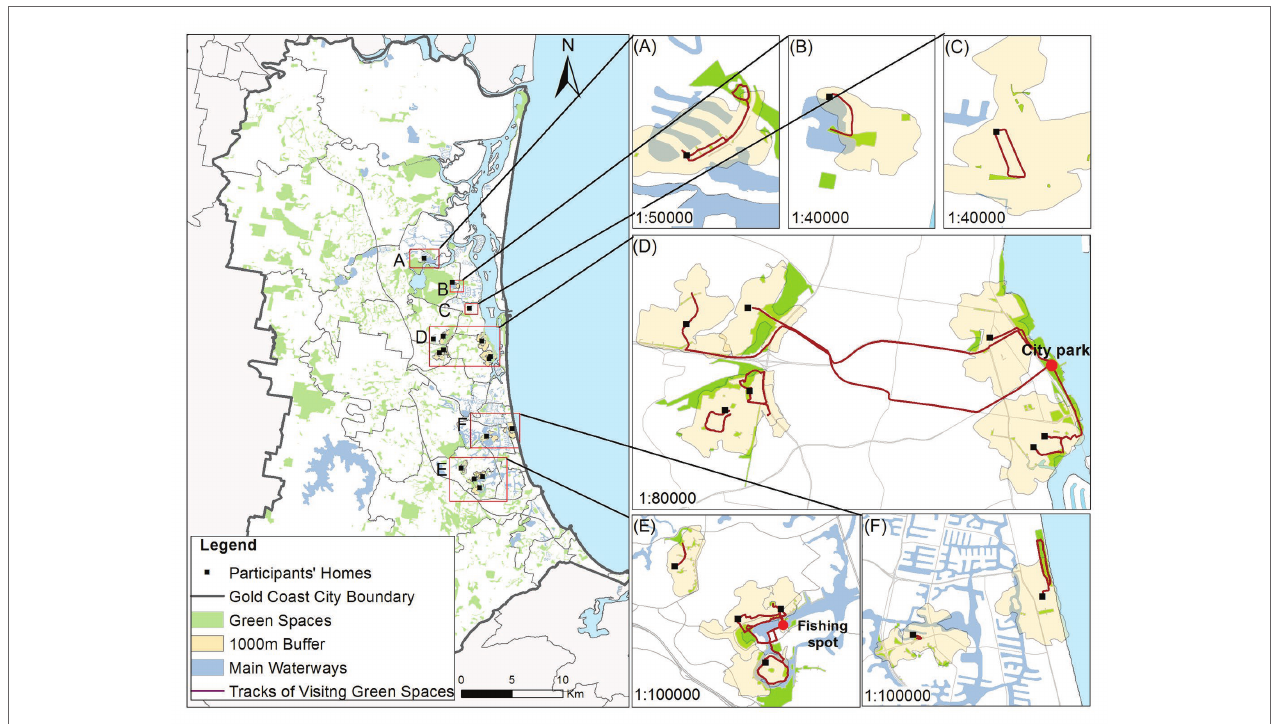
FIGURE 5 | The participants’ location and their travel maps to green spaces on the Gold Coast. (A - F) show detailed participants’ location and travel maps. (source: image produced by the author with spatial information obtained from the Australian Bureau of Statistics and the Gold Coast City